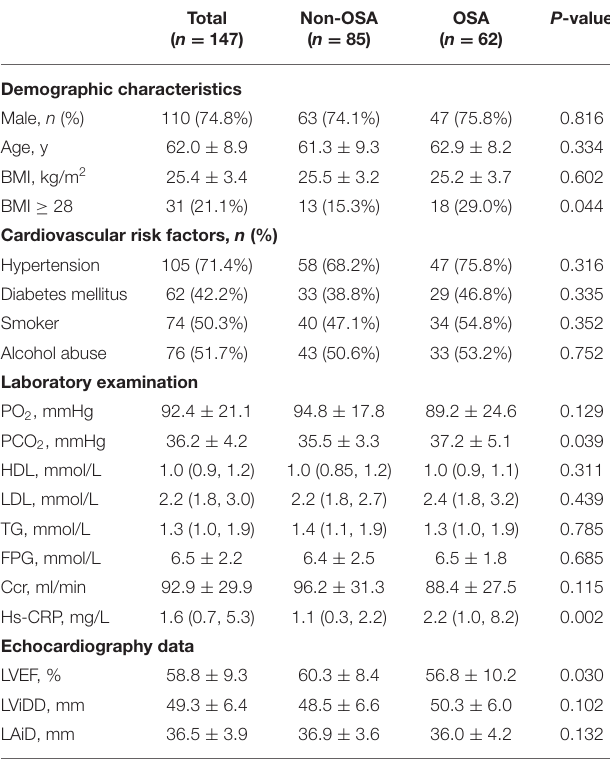
TABLE 1 | Baseline clinical data for